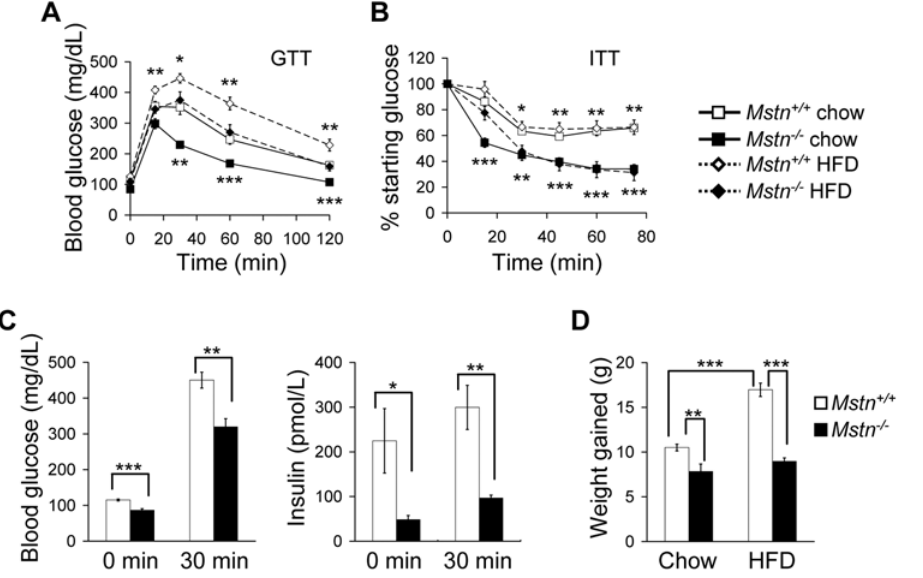
Figure 2. Mstn 2 / 2 mice have increased insulin sensitivity and reduced weight gain on standard chow and HFD. ( A ) Blood glucose levels during GTT of Mstn + / + and Mstn 2 / 2 mice on standard chow or HFD. n =8–16. ( B ) Percent of starting glucose during ITT of Mstn + / + and Mstn 2 / 2 mice on standard chow or HFD. n =6–10. ( C ) Blood glucose (left panel) and insulin (right panel) 0 and 30 minutes after glucose injection in fasted mice maintained on standard chow. n =6. ( D ) Body weight gained by Mstn + / + and Mstn 2 / 2 mice after 10 weeks on diets. n =7–16. * P , 0.05, ** P , 0.01, *** P , 0.001. A and B , P value symbols are for comparisons between genotypes on the same diet; below curves, mice on standard chow; above curves, mice on